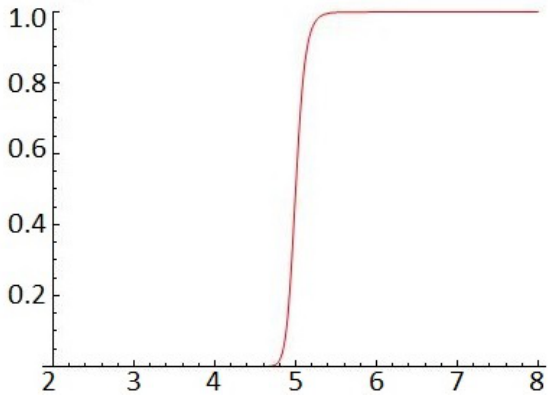
Fig. 2. Approximation of the shifted Heaviside step function by transmuted Stannard growth function for the following data: k = 26 , m = 2 . 1 , β = 1 , t r = 5 ; Hausdorff distance d = 0 . 112237